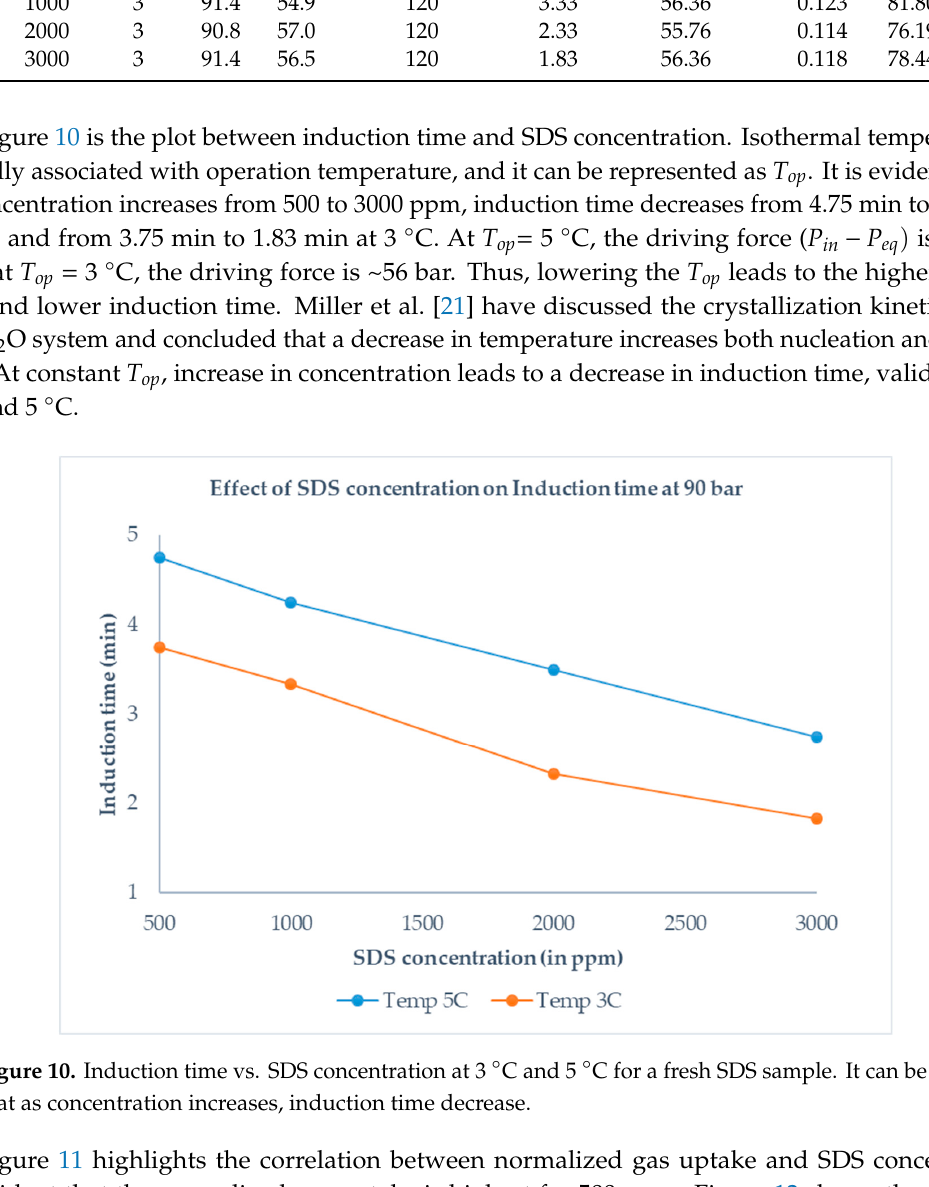
Table 6. Experimental results from isothermal experiments for fresh sample using rocking cell. Exp.